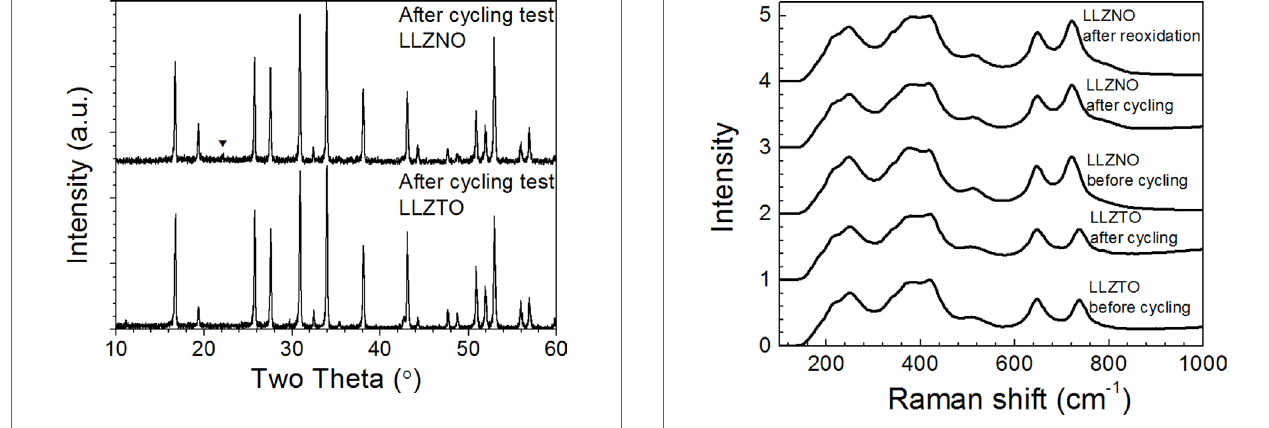
FigUre 7 | raman spectra of li 6.5 la 3 Zr 1.5 Ta 0.5 O 12 and li 6.5 la 3 Zr 1.5 nb 0.5 O 12 before and after Dc cycling at 23.5 ± 1°c; (top spectrum) llZnO after Dc cycling and after heat treatment at 600°c in air for 2 h .